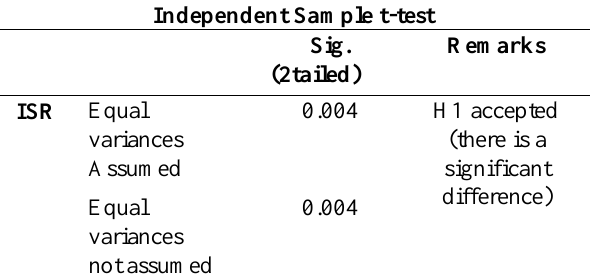
Table 4 Independent Sample t-test Independent Sample t-test